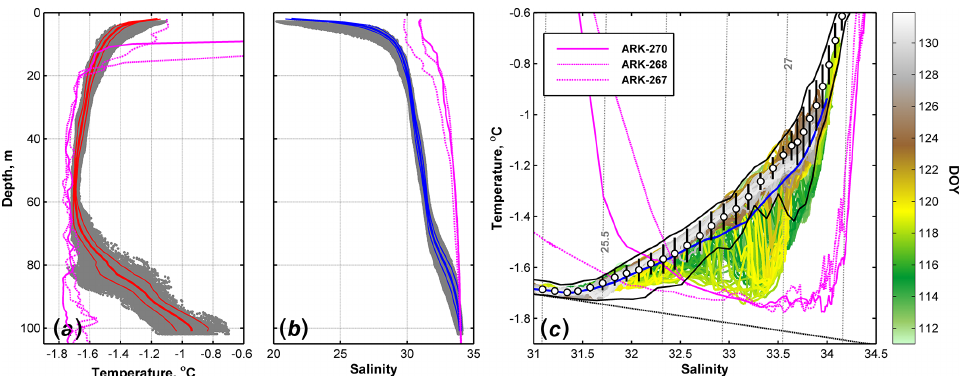
Figure 6. Scatterplot of all (a) temperatures and (b) salinities measured with the ITP. Red and blue lines indicate the mean and ± 1SD depicted with bold and thin lines, respectively. The magenta curves show profiles measured on board R/V Polarstern (ARK 267, ARK 268, and ARK 270; see Fig. 1a) in August 2008. (c) TS diagram of all ITP profiles and their mean TS approximation (blue line). White circles with vertical bars show the mean TS curve and standard deviation of temperatures for the ambient CTD profiles and the black lines encircle all TS data from ambient waters, both adopted from Dmitrenko et al. (2017). The dates of each TS profile (in yeardays) are indicated by the colour scale. Dashed grey lines are σ -zero isopycnals in kgm − 3 , while the dashed black line is the freezing line.